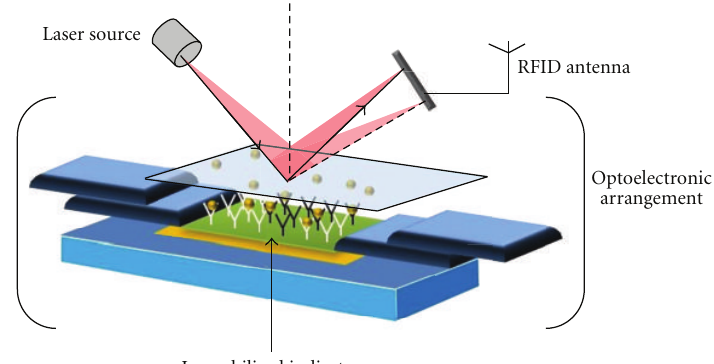
Figure 3: Architecture of an optical biosensor.